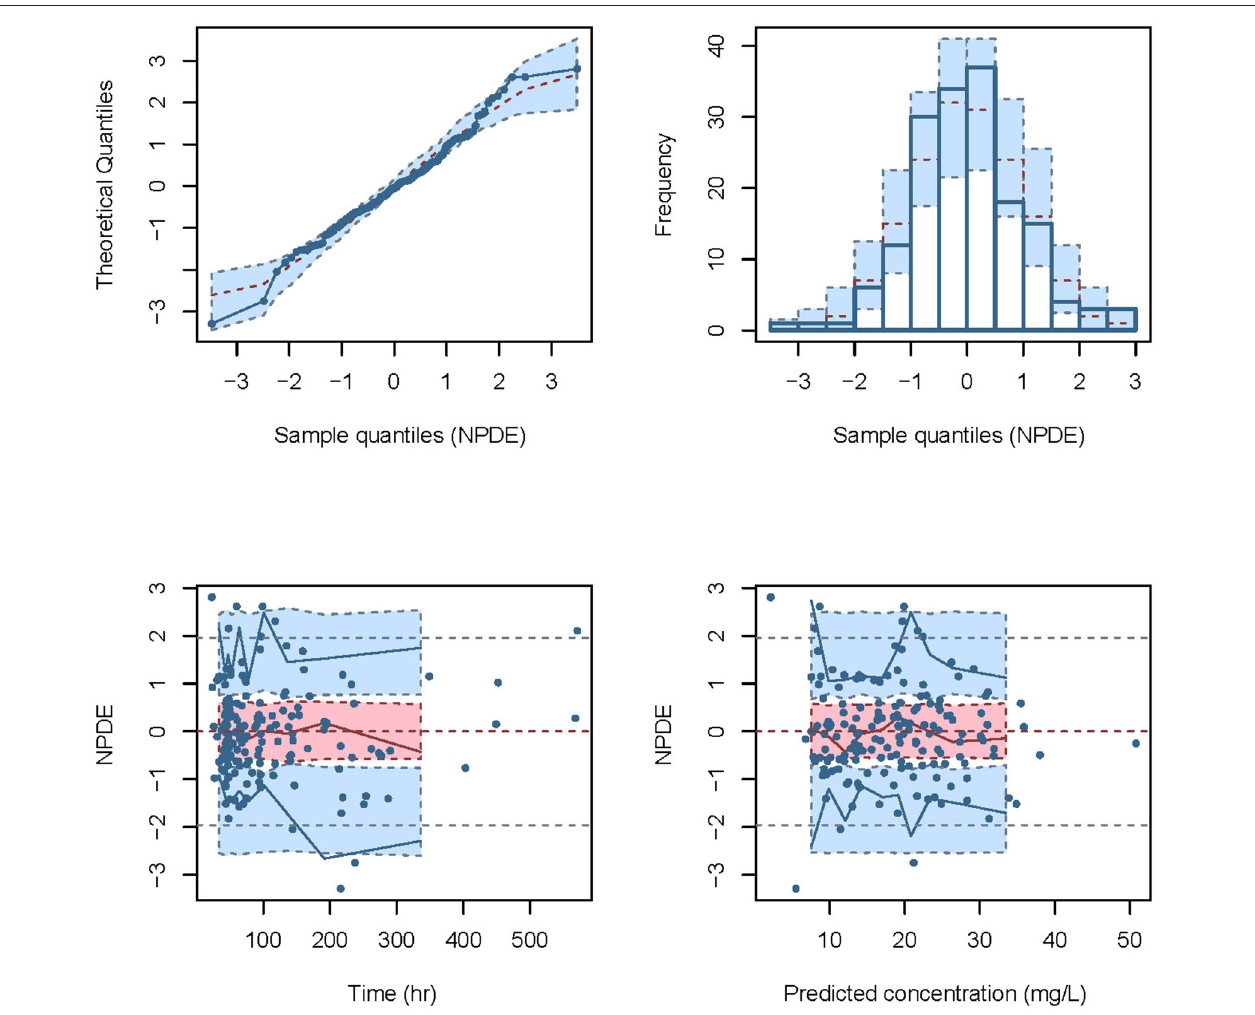
FIGURE 2 | Normalized prediction distribution error (NPDE) for the final model. Quantile-quantile plots of NPDE vs. the expected standard normal distribution (upper left). Histogram of NPDE values with the standard normal distribution overlayed (upper right). Scatter plot of the time vs. NPDE (lower left). Scatterplot of predictions vs. NPDE (lower